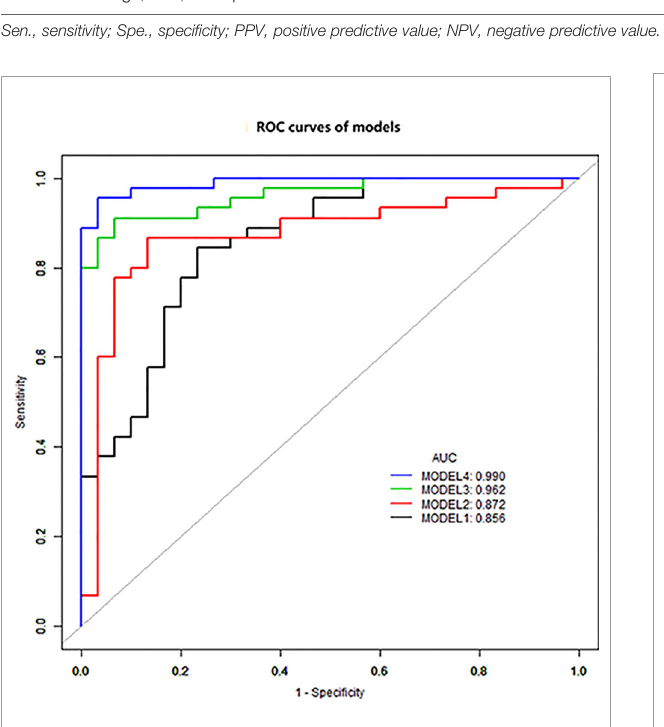
FIGURE 1 | ROC curve analysis. Model 4 has the best diagnostic performance (AUC = 0.989), followed by models 3, 2, and 1 (AUC = 0.962, 0.872, and 0.856, all p < 0.05).